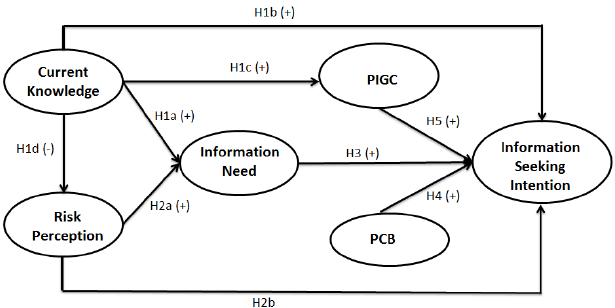
Figure 1. Research framework and research hypotheses (H1–H5) of consumers’ information seeking intention. PCB:Perceivedch annel beliefs; PIGC: Perceived information-gathering capacity. The “+” and “ − ” signs in brackets denote the direction of the